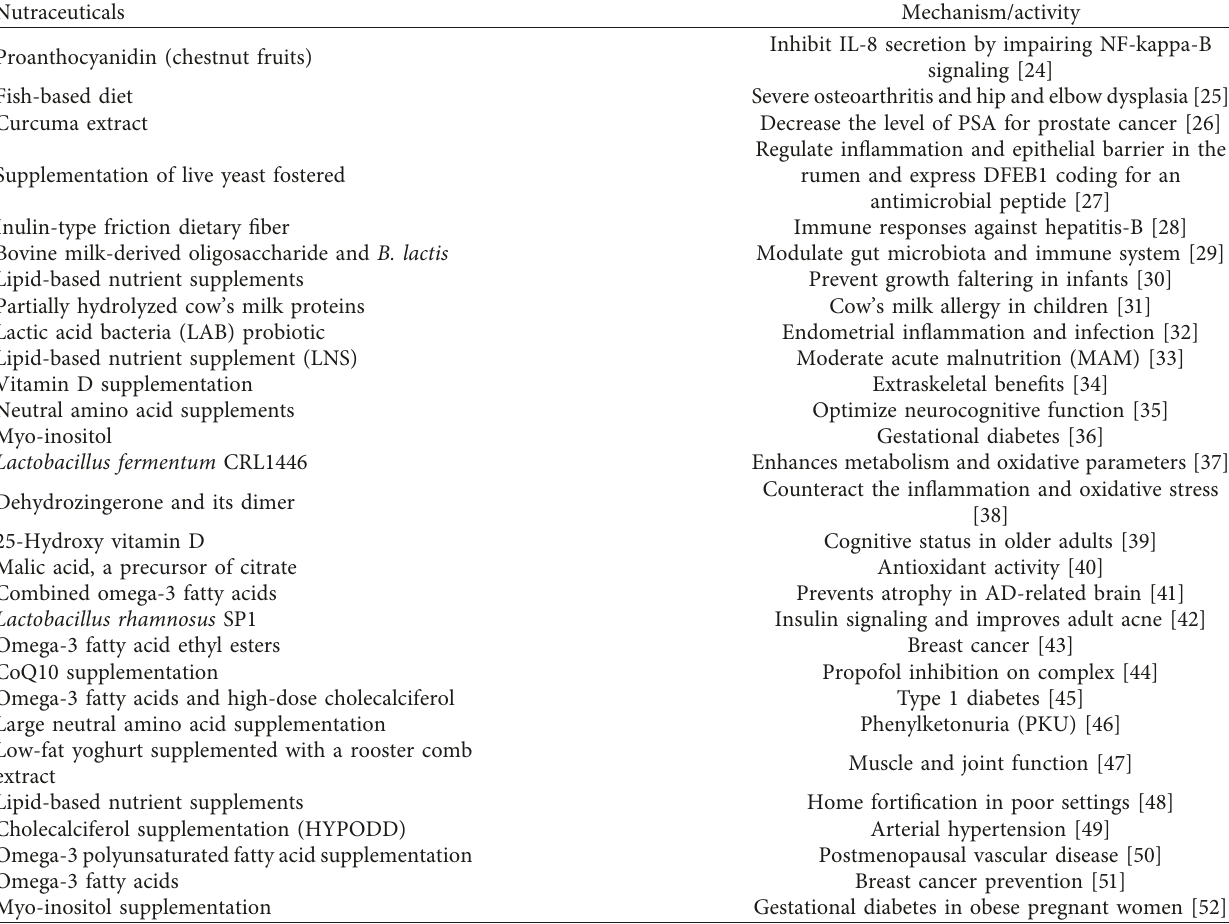
Table 1: Natural nutraceuticals along with